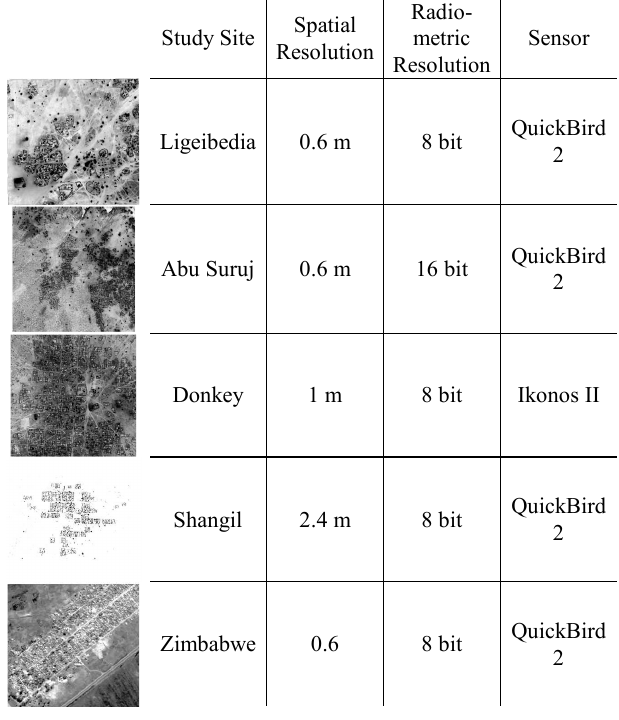
Table 1. Remote Sensing Data Specifications of the